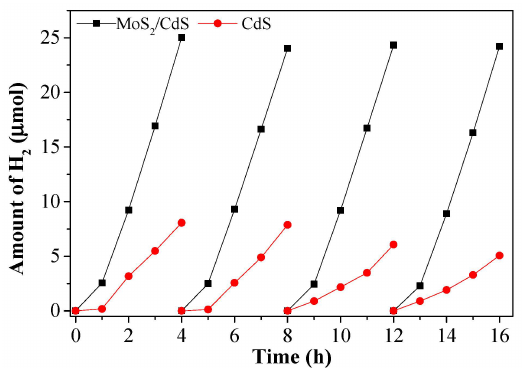
Figure 6. The stability of the activity over CdS and MoS 2 QDs/CdS under visible light irradiation (reaction conditions: 20 mg catalysts, 45 mL H 2 O containing 5 mL 0.02 M NaS and 0.025 M NaSO 3 , λ > 420